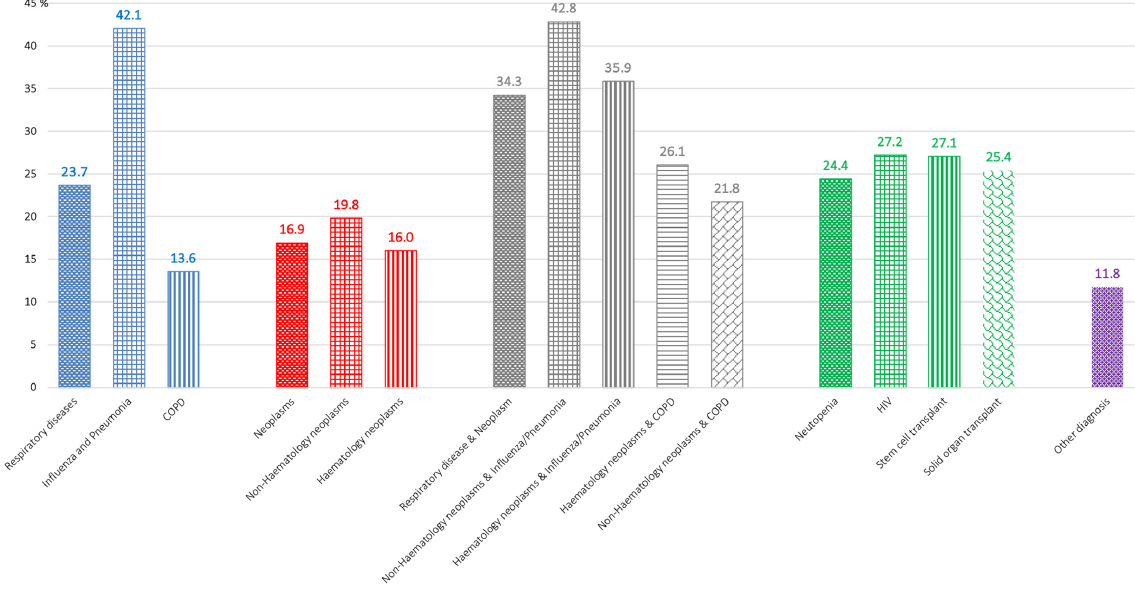
Figure 3. Comorbidities and main Case Fatality Rates (percent).